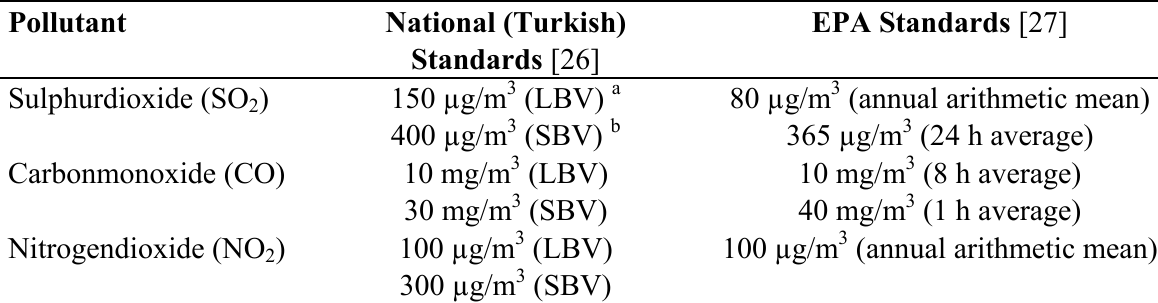
Table 1. Ambient Air Quality